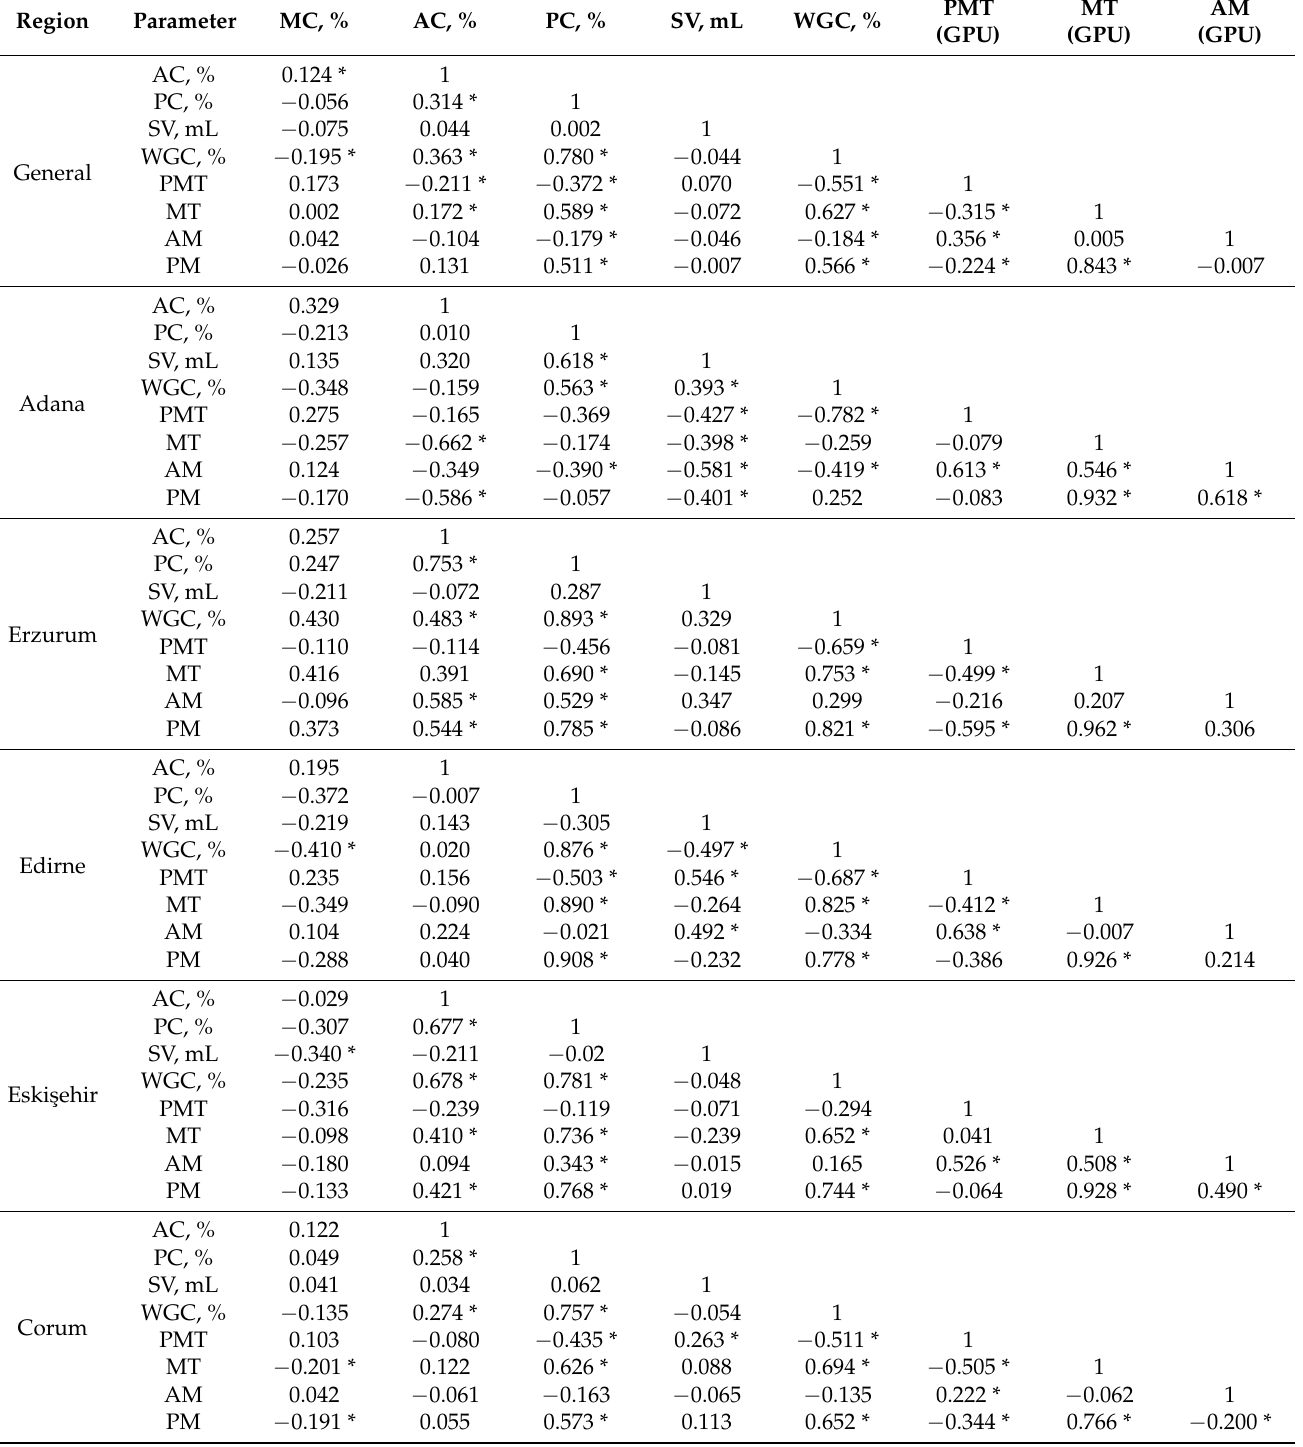
Table 1. General and regional correlation coefficients ( r ) between conventional and GlutoPeak